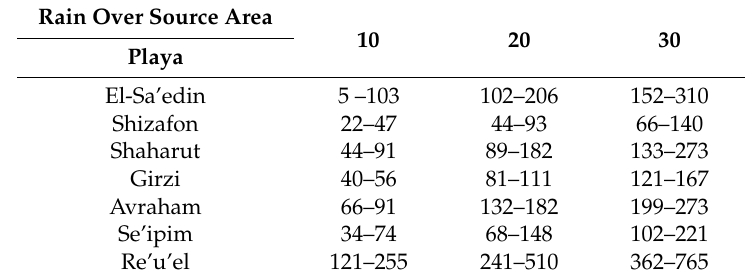
Table 5. Potential water column depth (mm) over the recharge playa’s bed due to runoff generated from the entire catchment, including the playa’s adjacent hillslopes, and according to rainfall